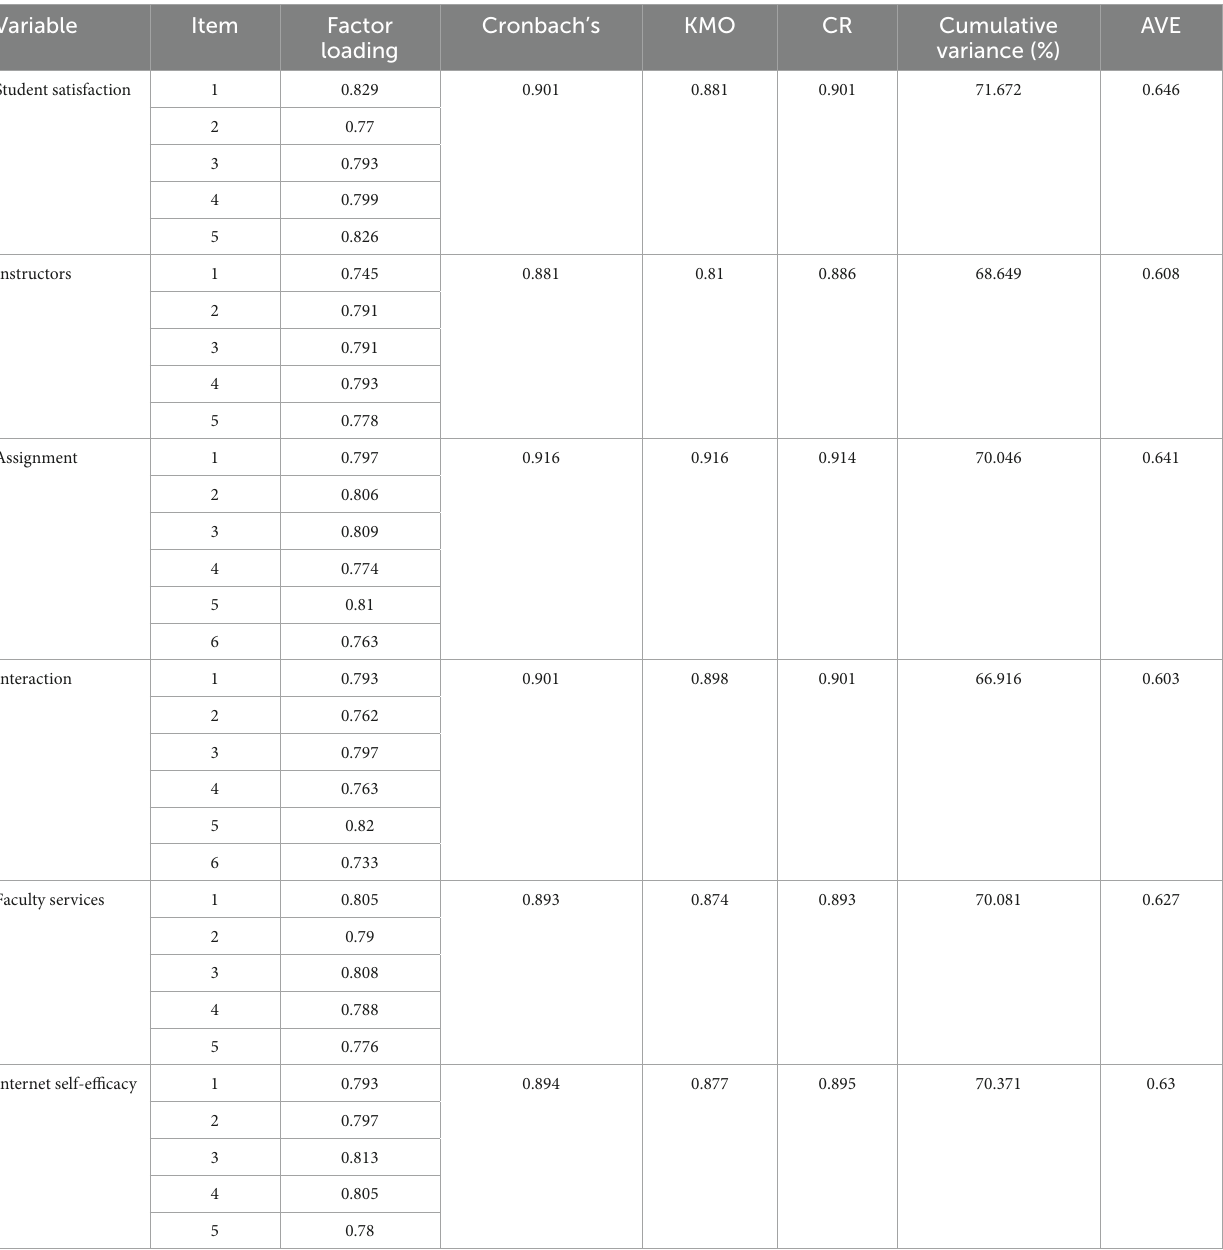
TABLE 4 Reliability and validity analysis table. Variable